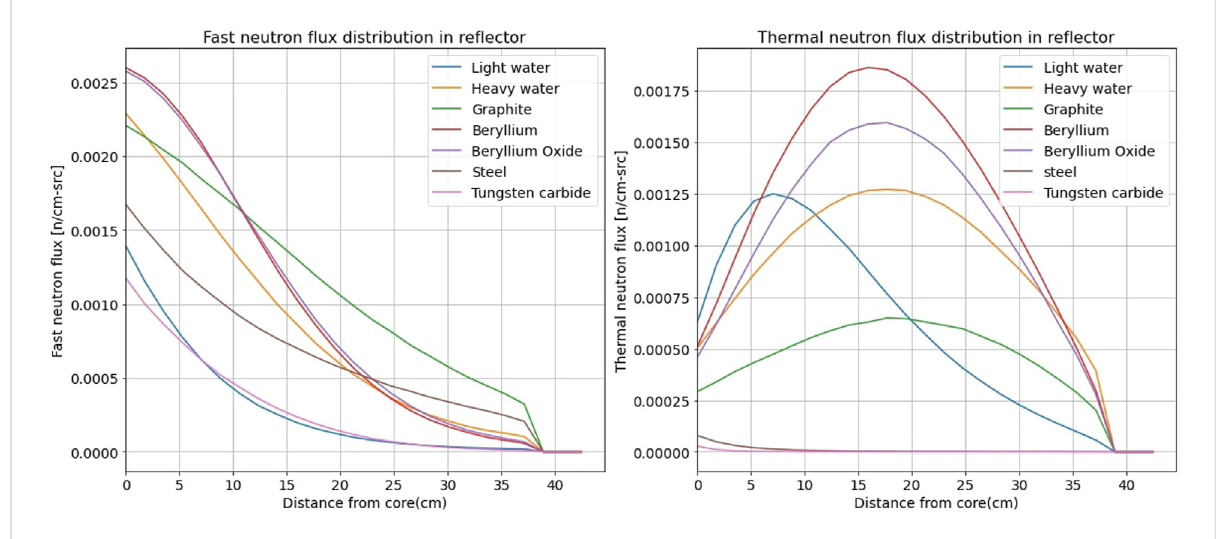
FIGURE 5 Values of neutron fl ux versus the distance away from FA